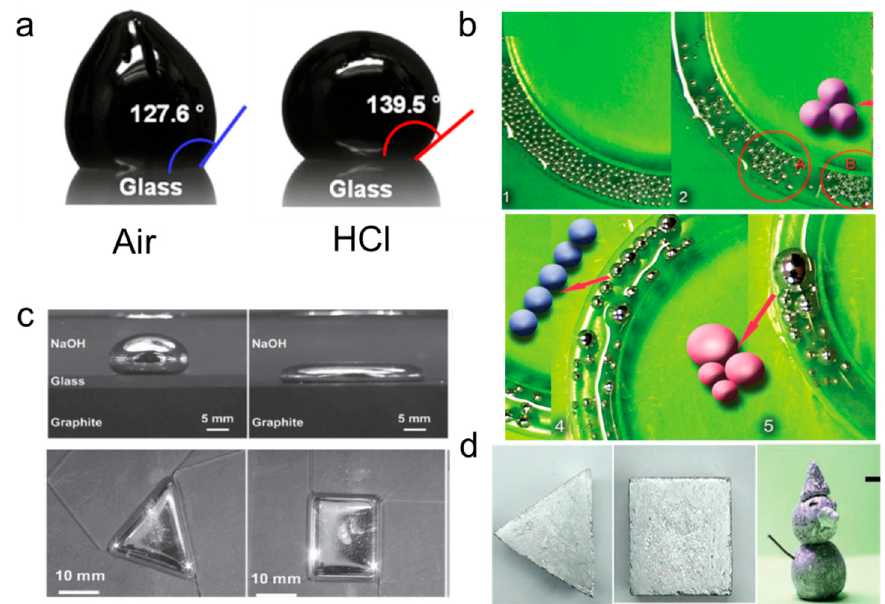
Figure 1. Liquid metal morphology and its control methods. ( a ) The morphology of liquid metal droplets with and without oxide. Reprinted with permission from [26]. Copyright (2013) American Chemical Society. ( b ) The dispersion and merge of liquid metal [27]. Red circle A and B shows the liquid metal droplets about to reunite. Copyright (2015) WILEY-VCH. ( c ) The transformation of liquid metal droplets on graphite with a different shape in an electrolyte [30]. Copyright (2015) WILEY-VCH. ( d ) Different shapes of oxide-rich liquid metal [36]. Copyright (2020) WILEY-VCH.